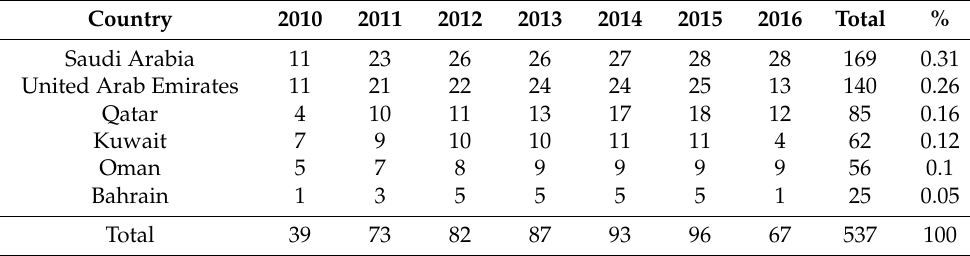
Table 1. Sample distribution based on country and